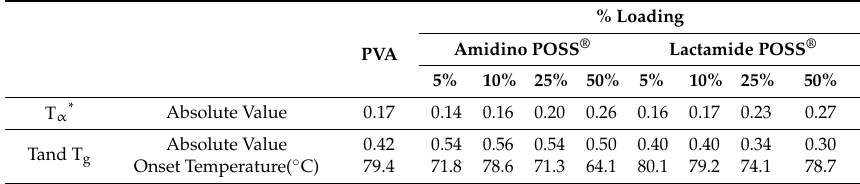
Table 4. T α * (alpha star transition) & Tand T g , for the different nanocomposite membranes. % Loading Amidino POSS PVA